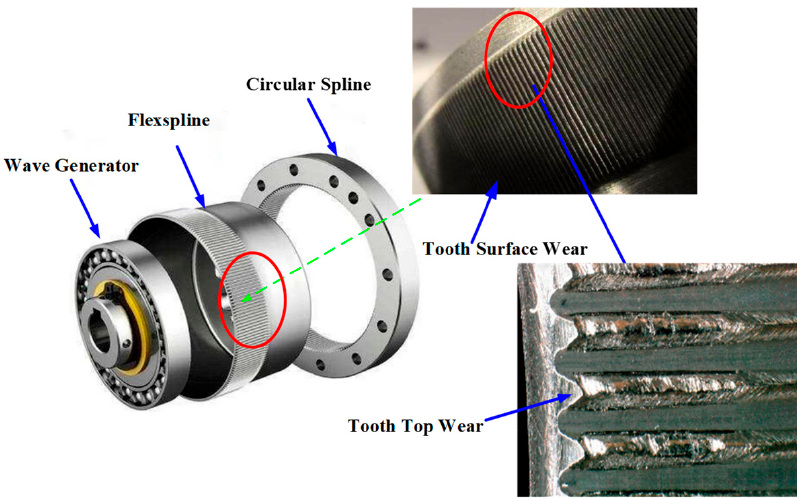
Figure 1. Flexspline tooth surface wear of a harmonic drive gear.